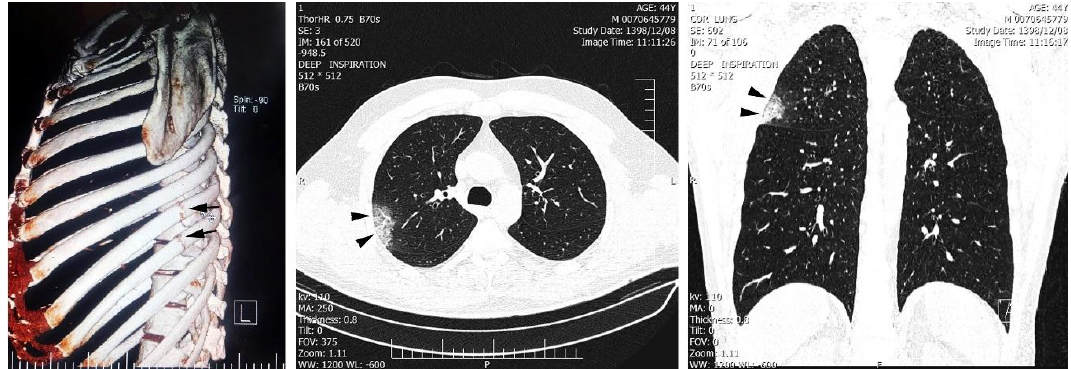
Figure 1. Fractures are seen in the left 8th and 9th ribs (arrow). Peripheral patchy ground-glass opacity in the right upper lobe is observed due to viral pneumonia (arrowheads). Neither pleural effusion nor lymphadenopathy were found. Written informed consent was obtained from the patient for publication of this case report.